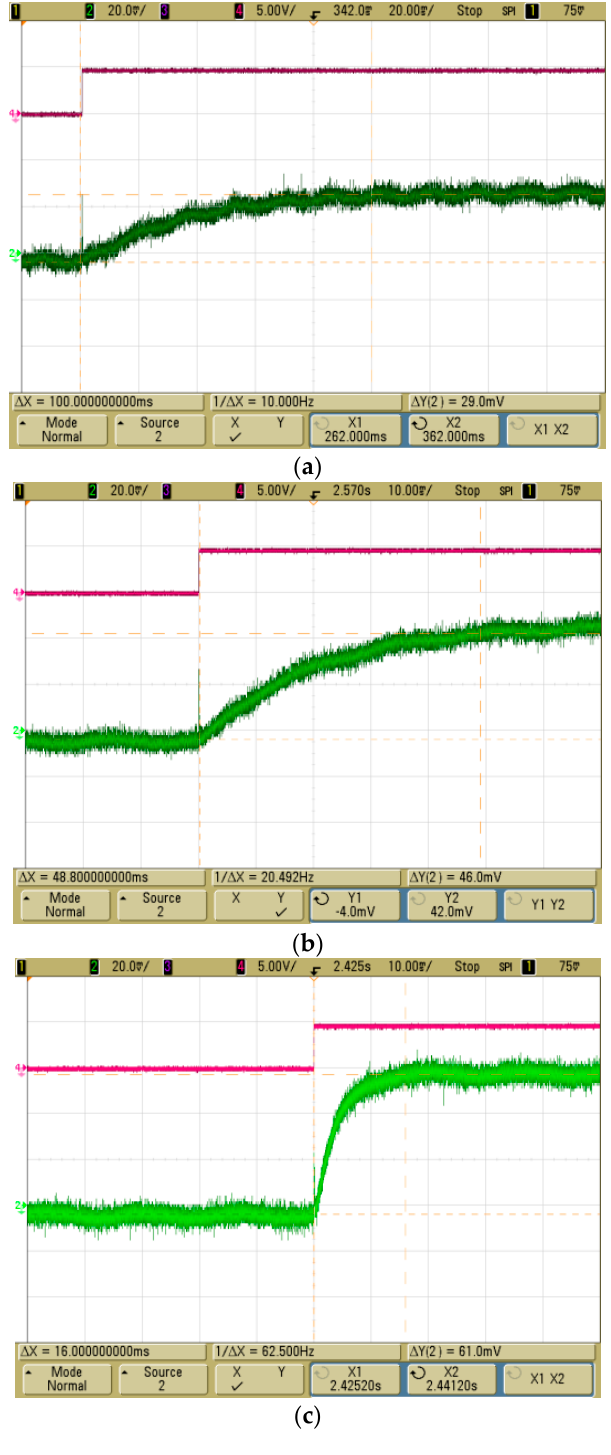
Figure 11. Comparison between response times and output voltages of thermopiles; ( a ) Teflon (100 ms, 29 mV), ( b ) SU-8 (48.8 ms, 46 mV), ( c ) PI (16 ms, 61 mV). Table 5. Comparison between response times and output voltages [14–19].